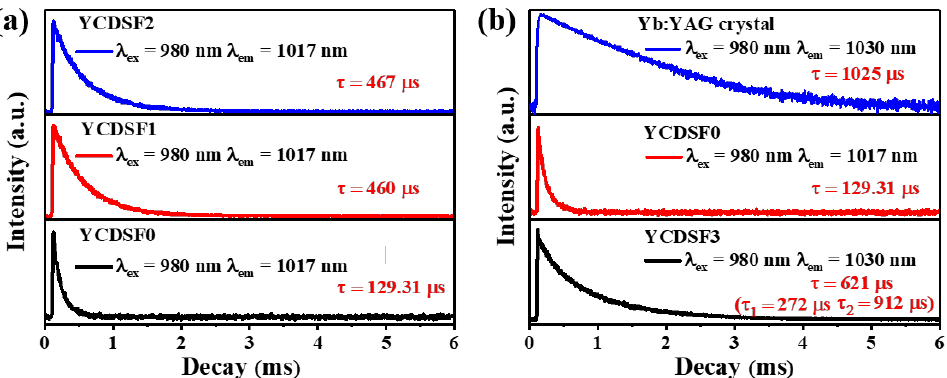
Figure 5. Fluorescence decay curves of ( a ) YCDSF0, YCDSF1 and YCDSF2, ( b ) Yb:YAG crystal, YCDSF0 and YCDSF3.